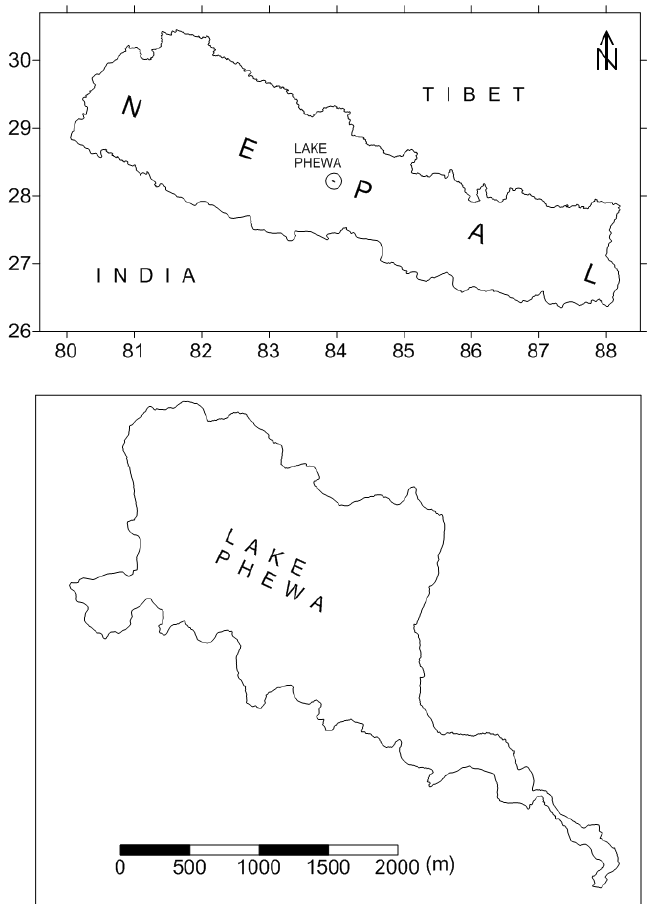
Figure 1. Location of Lake Phewa, the Study Area of the Present